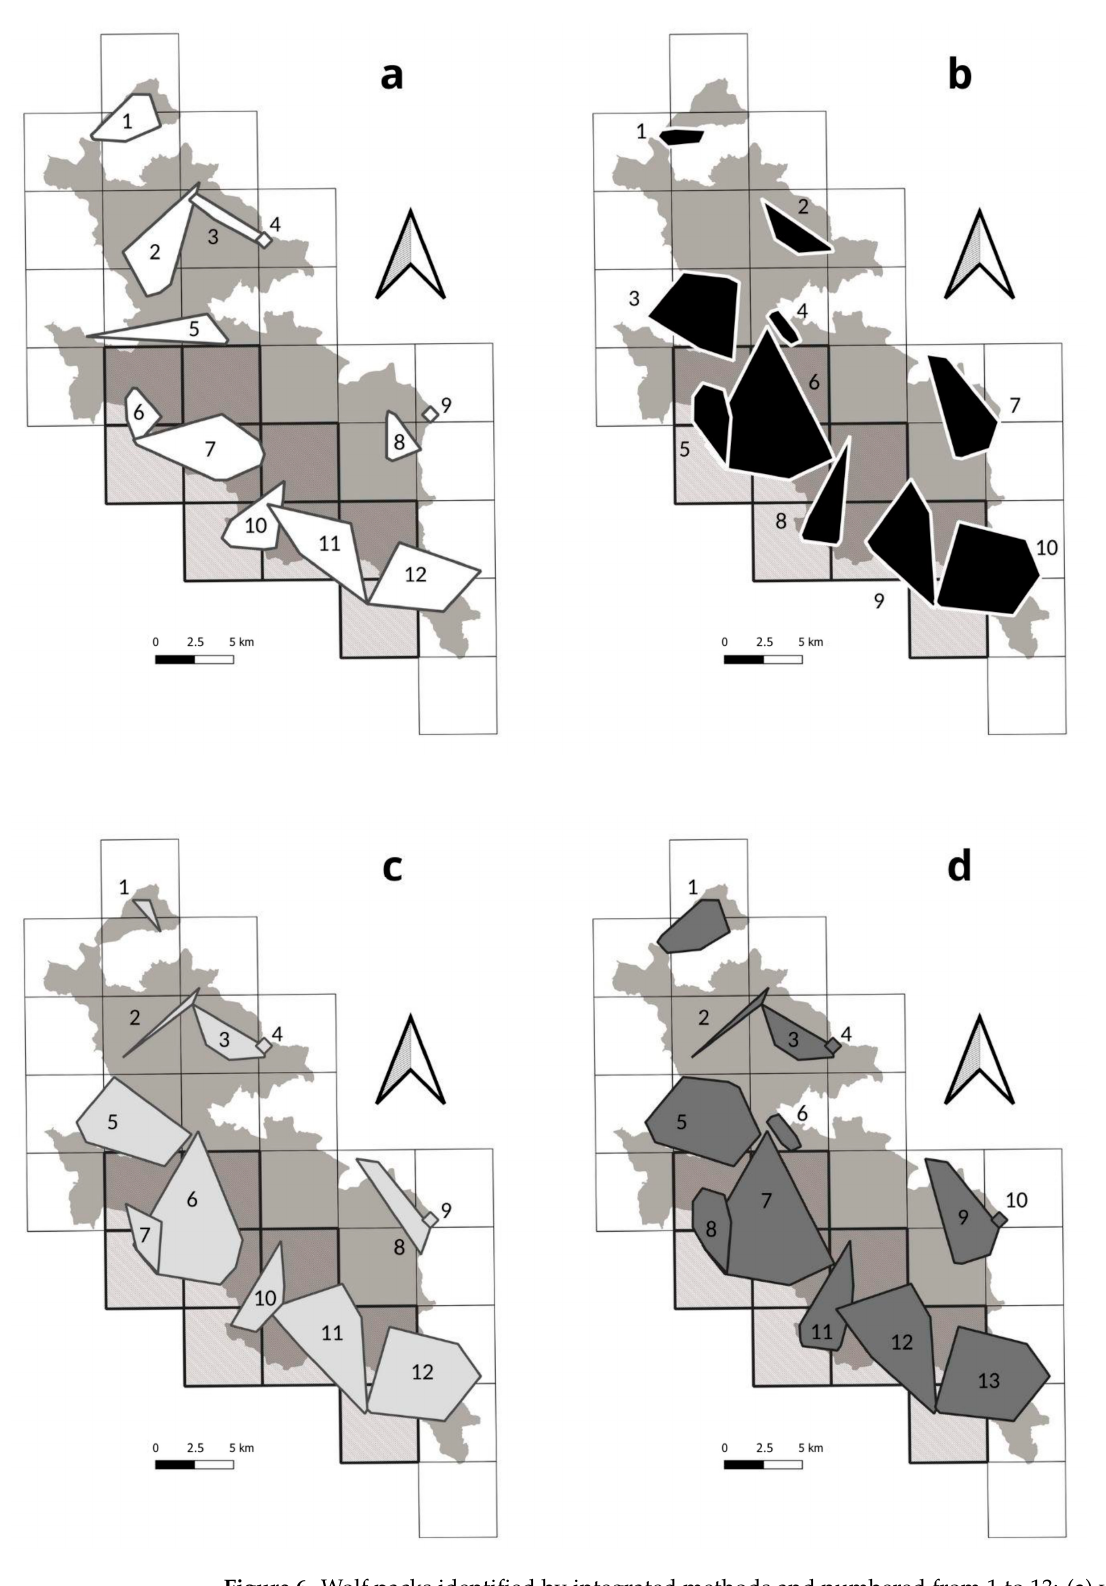
Figure 6. Wolf packs identi fi ed by integrated methods and numbered from 1 to 13: ( a ) wolf howling and camera trapping; ( b ) wolf howling and non-invasive genetic sampling; ( c ) camera trapping and non-invasive genetic sampling; ( d ) wolf howling, camera trapping and non-invasive genetic sampling.